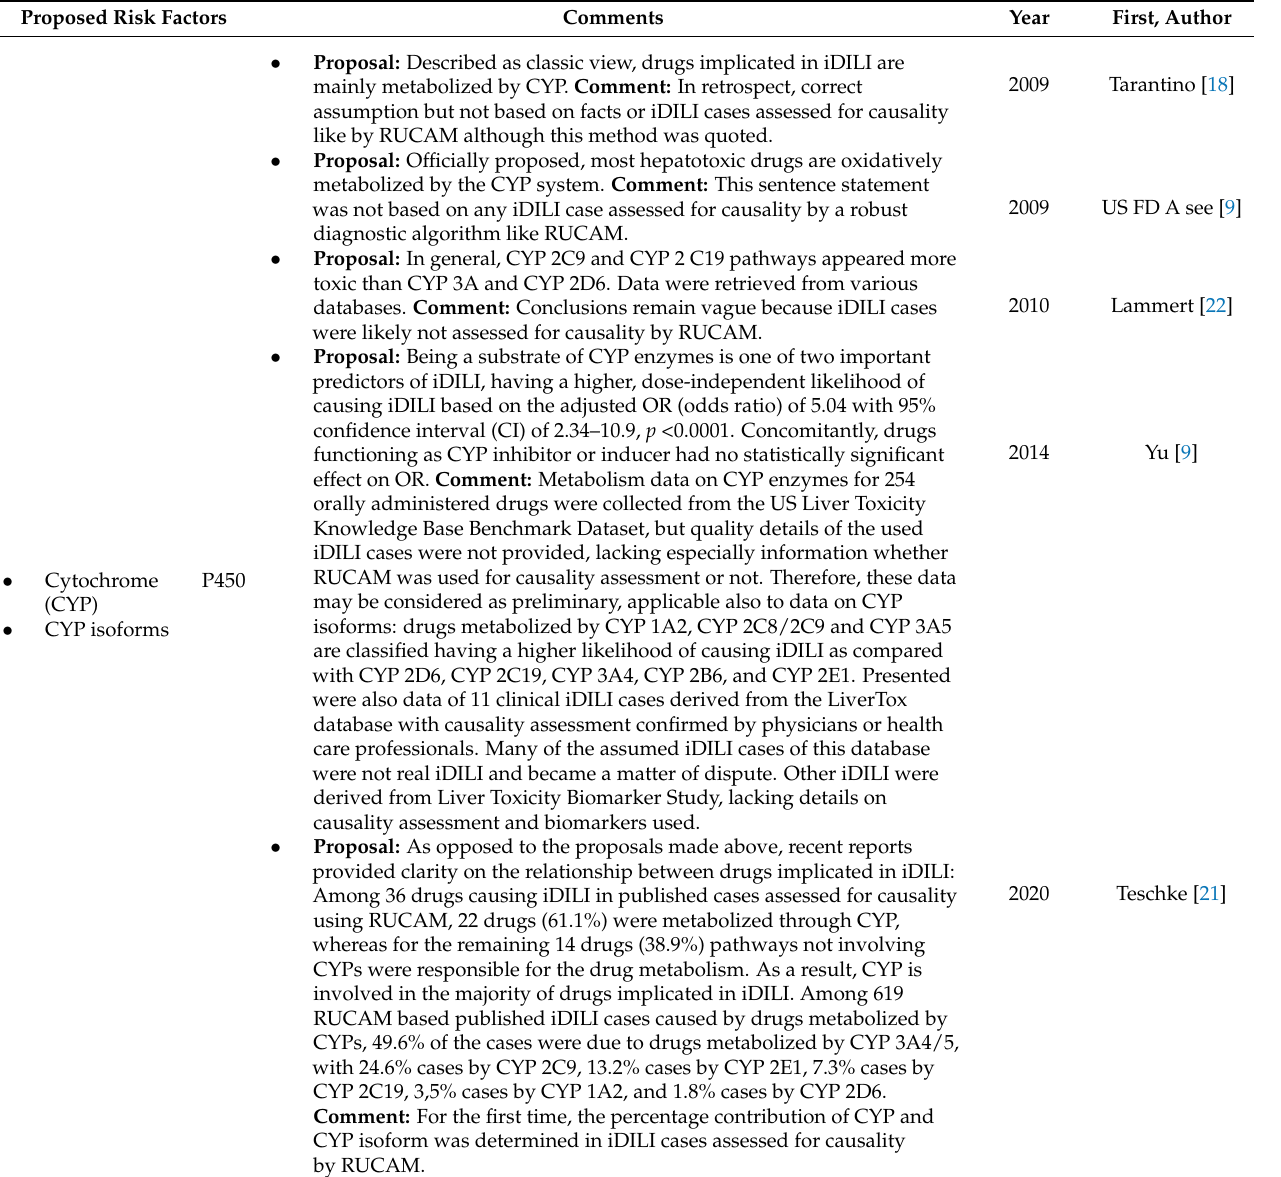
Table 1. Listing of published proposals for potential risk factors of iDILI with focus on cytochrome P450, drug dose, metabolic drug parameters and drug